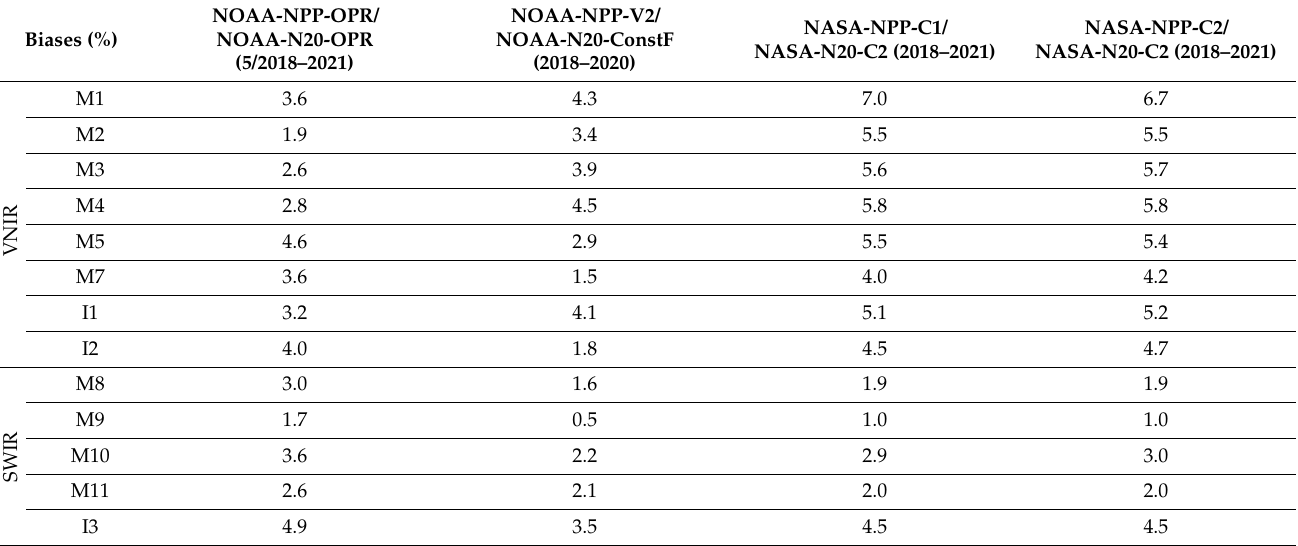
Table 5. Summary of the NOAA-20 and S-NPP inter-satellite biases in the NOAA and NASA- generated VIIRS RSB